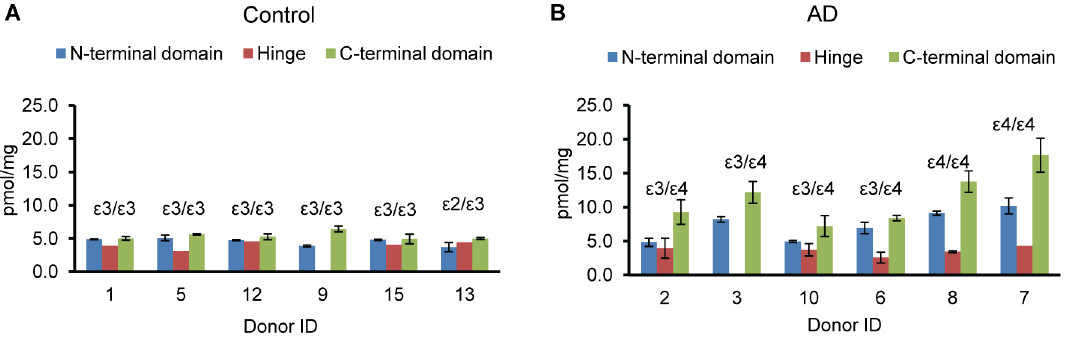
Figure 2. Quantification of total apoE in whole frontal cortex homogenate. Measurements were performed on the control (A) and severe AD (B) frontal cortex. The apoE genotype is shown for each donor. The concentration of total apoE in pmol/mg total protein was calculated based on peptides in the N-terminal, hinge, and C-terminal domains and is color coordinated. The concentration was calculated for three experimental replicates by monitoring three transitions per individual peptide. For N-terminal and C-terminal domain the data for three signature peptides were combined. All final data are presented as the mean 6 SD.